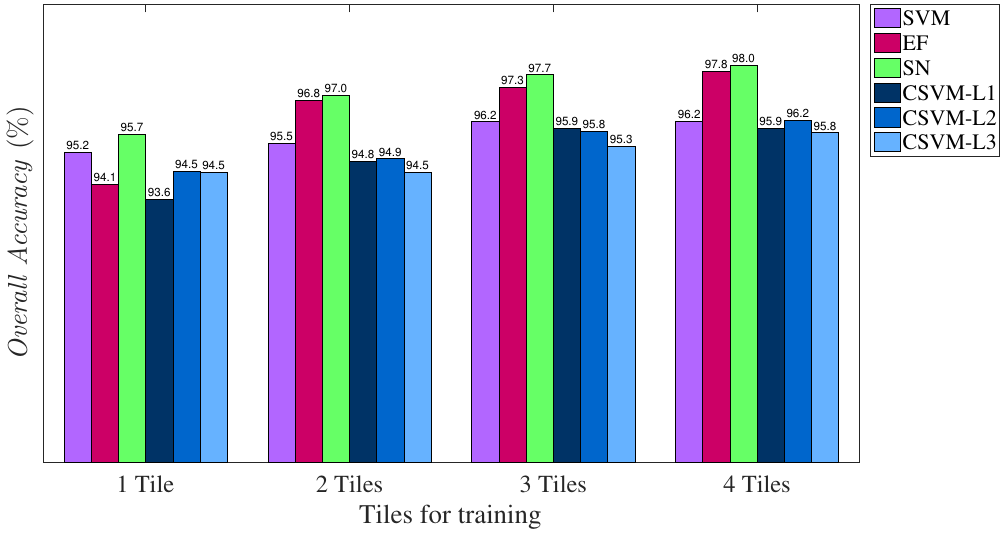
Figure 10. Overall Accuracy of Amazon Biome obtained from SVM, EF, SN, and CSVM (after each layer) using one, two, three, and four tiles for